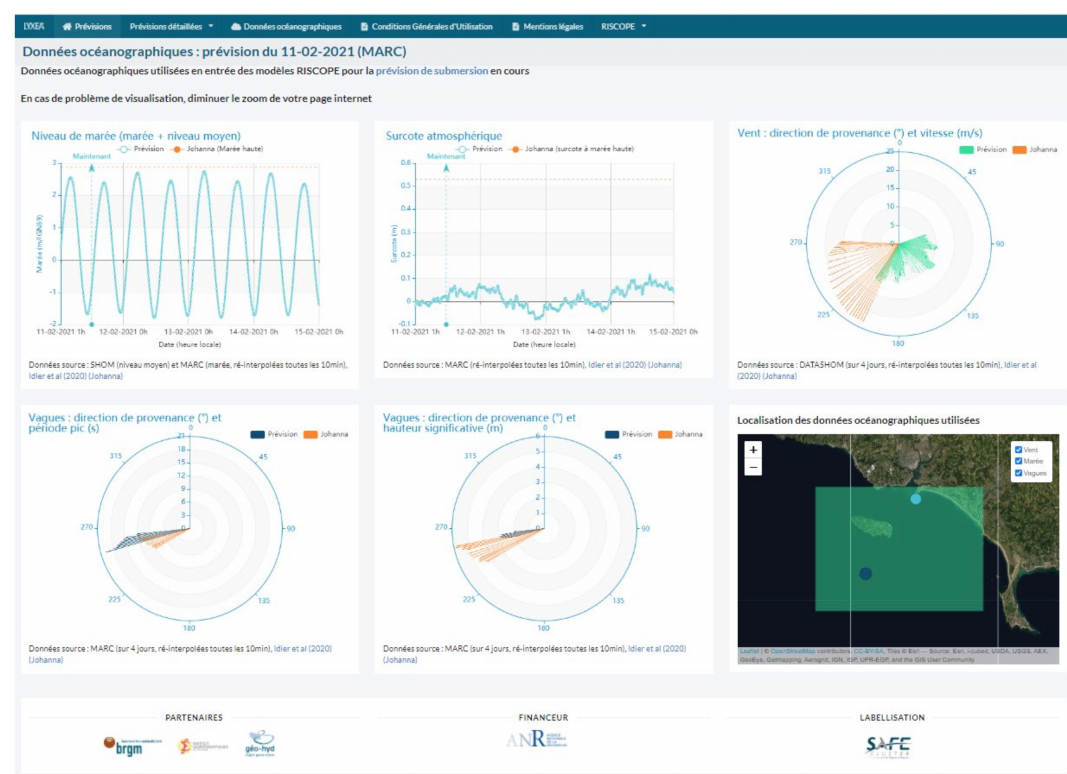
Figure A7. Screen capture of the FEWS webpage showing the forcing conditions X (here, X = X MARC ). The forcing conditions in orange correspond to the last major flooding event (10 March 2008, Windstorm